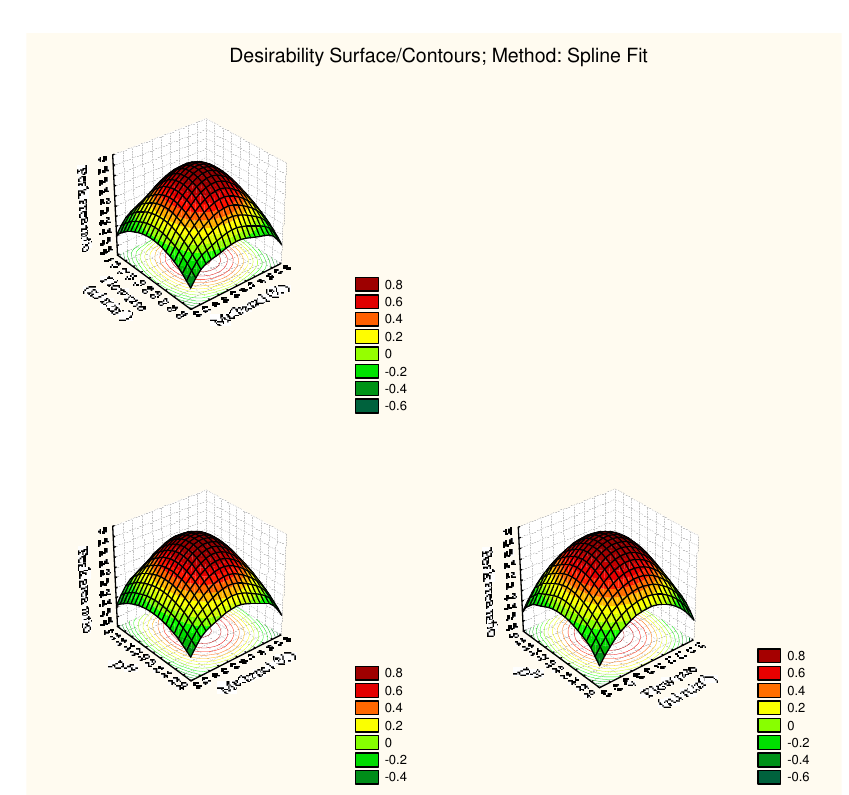
Figure 4 . Three-dimensional plot of the response surface for Y (found drug peak area ratio). (a) Variation of the response Y as a function of x (%methanol) and x (flow rate);fixed 1 2 factor:x (pH)=3.0 (b) Variation of the response Y as a function of x (%methanol) and 3 1 x (pH) fixed factor:x (flow rate ) =1.0 mL min -1 (c) Variation of the response Y as a 3 2 function of x (flow rate) and x (pH);fixed factor x (% methanol) = 50 % 2 3 1